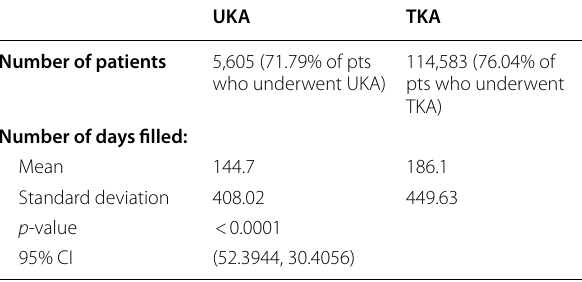
Table 6 Days of opioid use following TKA and UKA